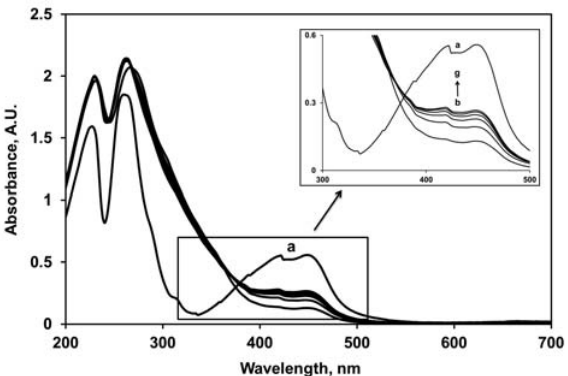
SO ). Inset: fluorescence emission 2 4